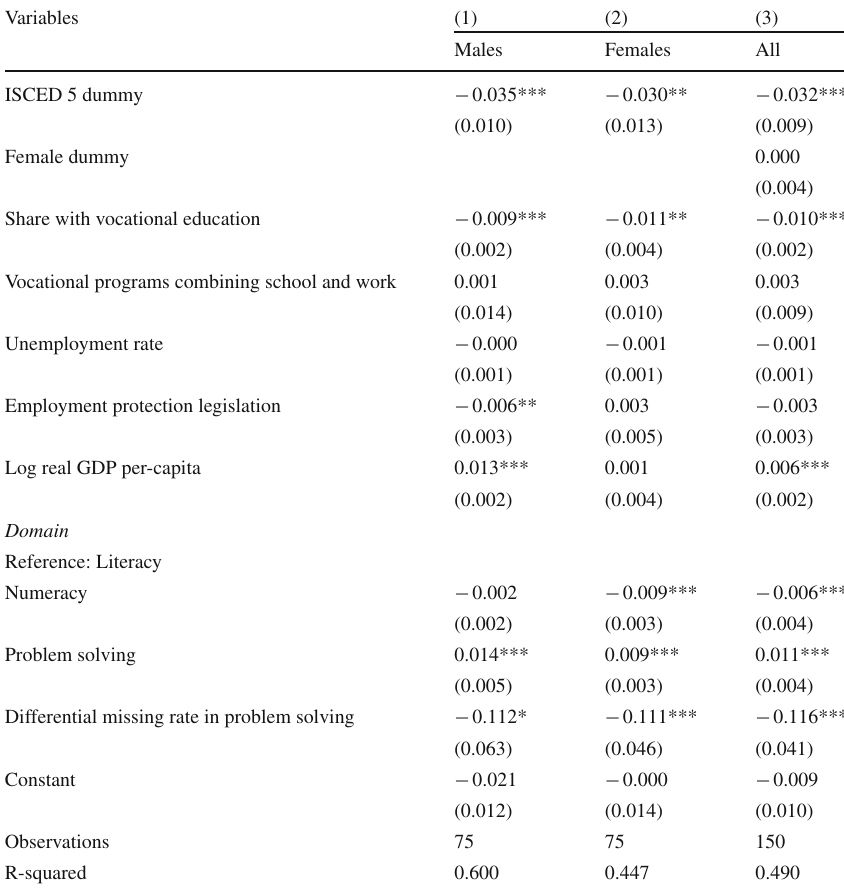
Table 5 Partial correlations between estimated ATEs and country specific effects